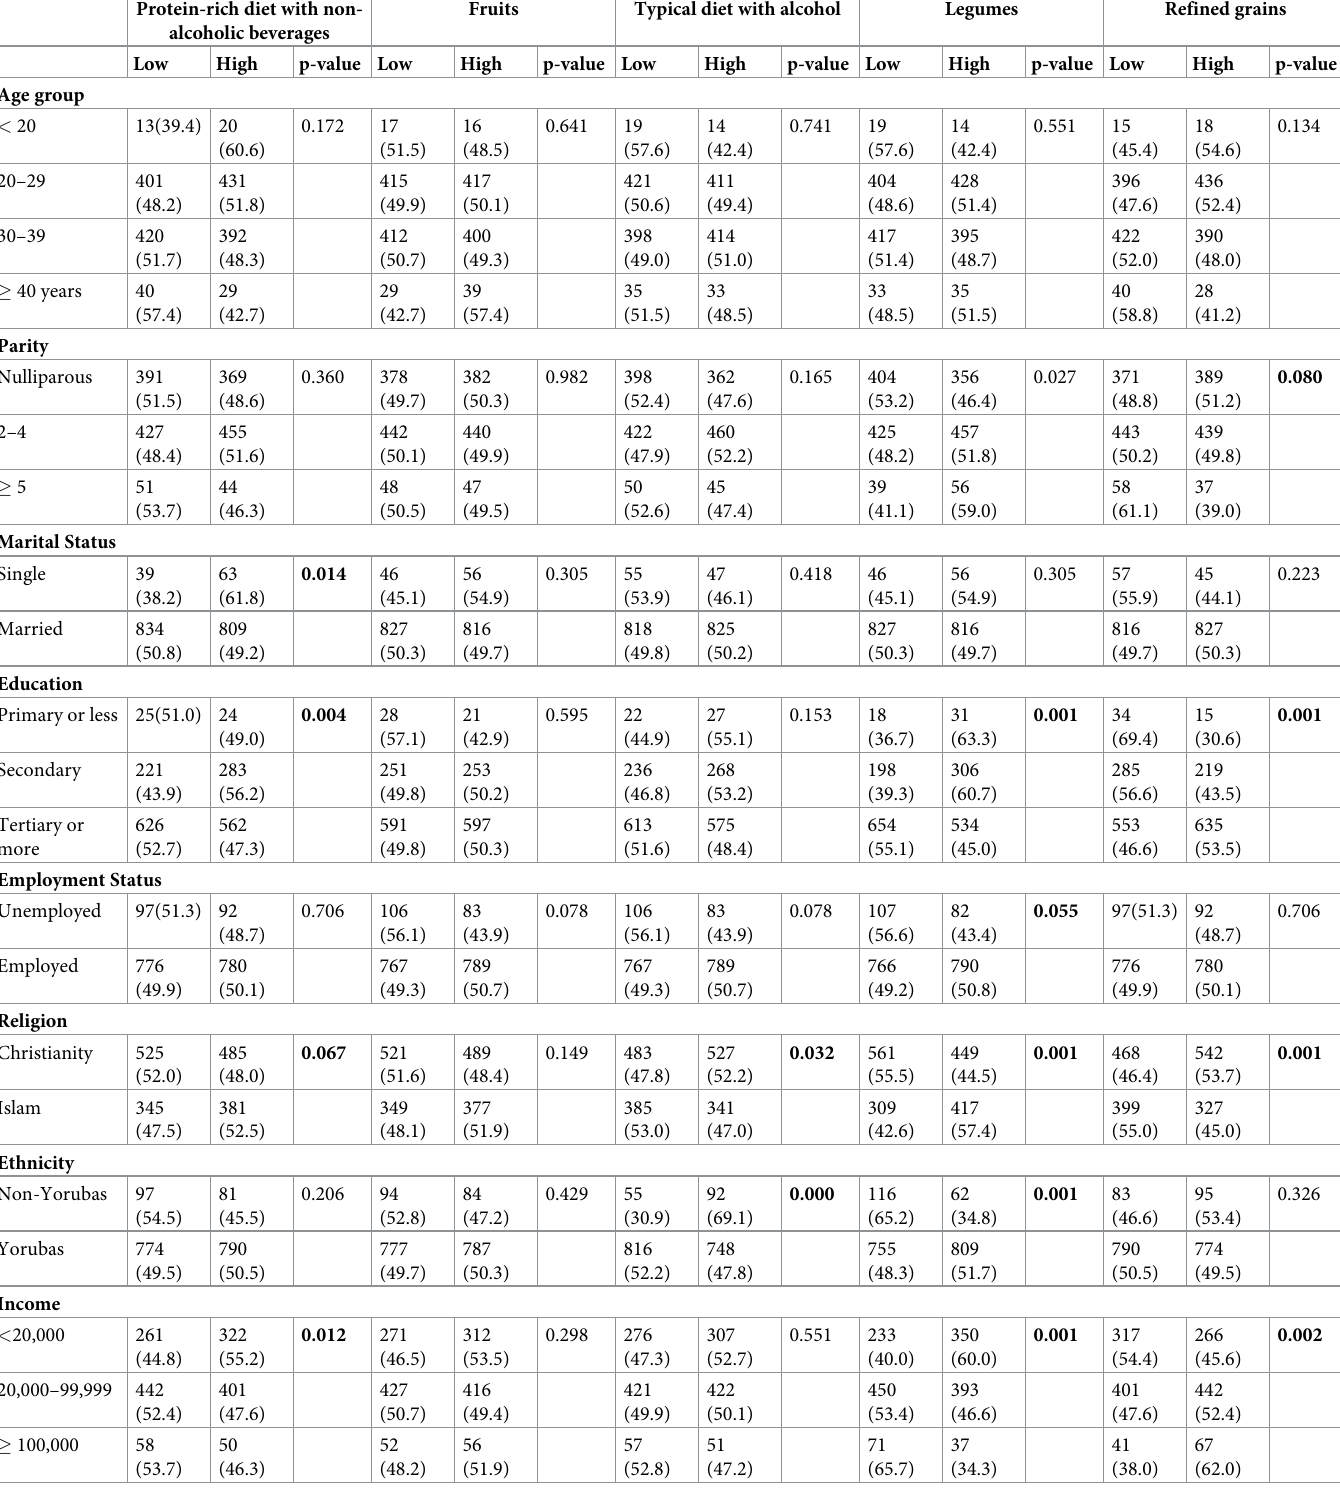
Table 4. Association between participants’ sociodemographic characteristics and dietary patterns. Protein-rich diet with non- Fruits Typical diet with alcohol Legumes Refined grains alcoholic beverages Low High p-value Low High p-value Low High p-value Low High p-value Low High